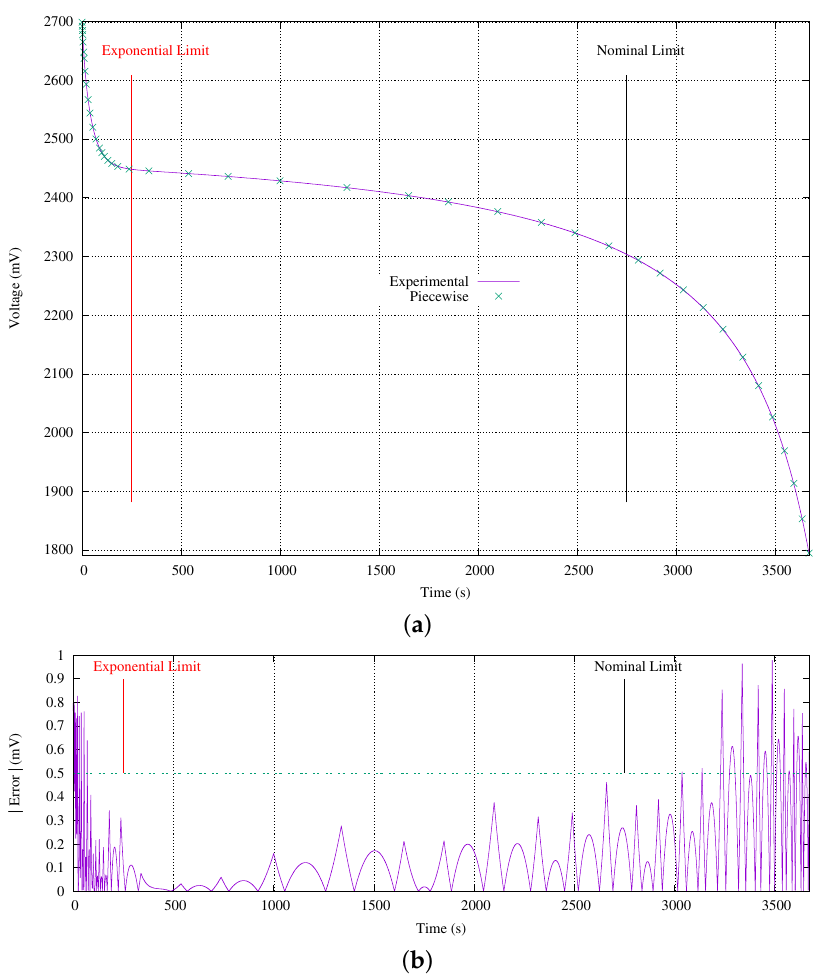
Figure 8. Battery model: ( a ) Experimental measurements and 40 sections piecewise function. ( b ) Ab- solute error between measured data and piecewise